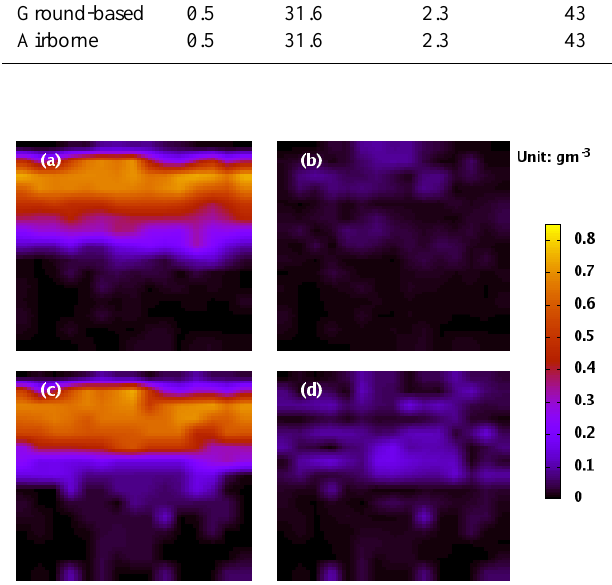
Figure 5. The stratocumulus clouds retrieved using the ground-based and airborne setups, Fig. 5. The stratocumulus clouds retrieved using the ground-based as well as the corresponding images of error. (a) Retrieved liquid water field by the ground-based setup; (b) The error of the ground-based retrieval; (c) Retrieved liquid and airborne setups, as well as the corresponding images of error. water field by the airborne setup; (d) The error of the airborne retrieval. (a) Retrieved liquid water field by the ground-based setup; (b) the error of the ground-based retrieval; (c) retrieved liquid water field by the airborne setup; (d) the error of the airborne retrieval.